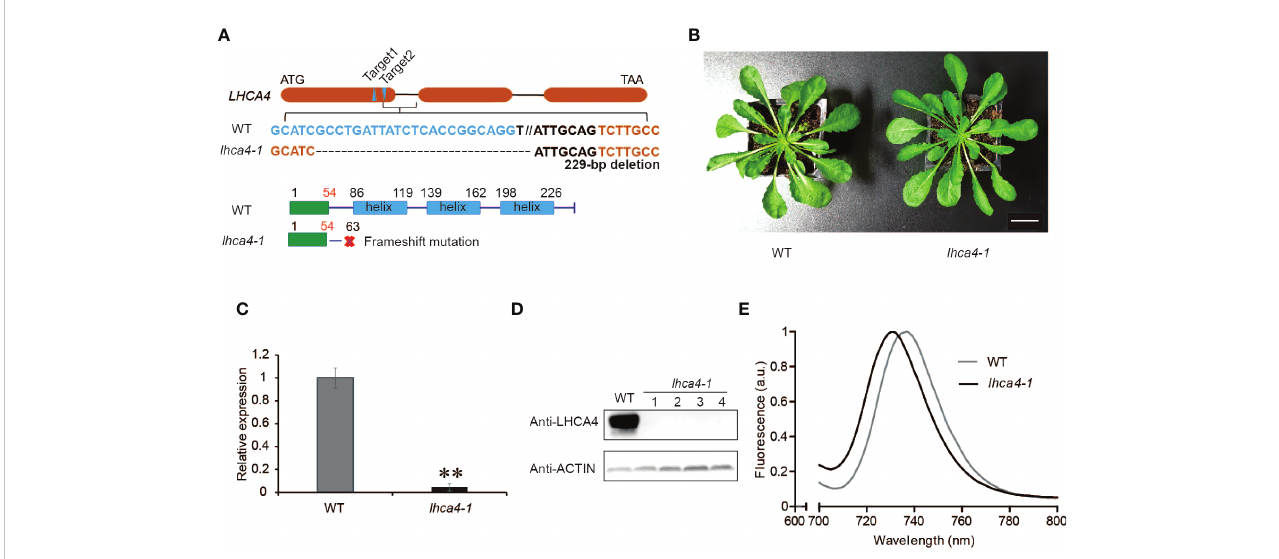
FIGURE 1 Characterization of the lhca4-1 mutant. (A) Schematic diagram of the LHCA4 locus showing the target sites of sgRNAs to generate the lhca4-1 mutant. (B) Representative rosette phenotype of the wild type (WT) and lhca4-1 (scale bars = 2 cm). (C) Relative LHCA4 expression levels as detected by reverse transcription quantitative PCR (RT-qPCR) analysis in the WT and lhca4-1 (using the two ‐ tailed Student ’ s t ‐ test; **signi fi cant at P < 0.01). (D) LHCA4 abundance in the WT and four lhca4-1 plants, as detected by immunoblotting. ACTIN served as loading control. (E) Low-temperature (77K) fl uorescence emission spectra (excitation at 440 nm) of the WT and lhca4-1 . The spectra were normalized to their maximal emission, which was set to